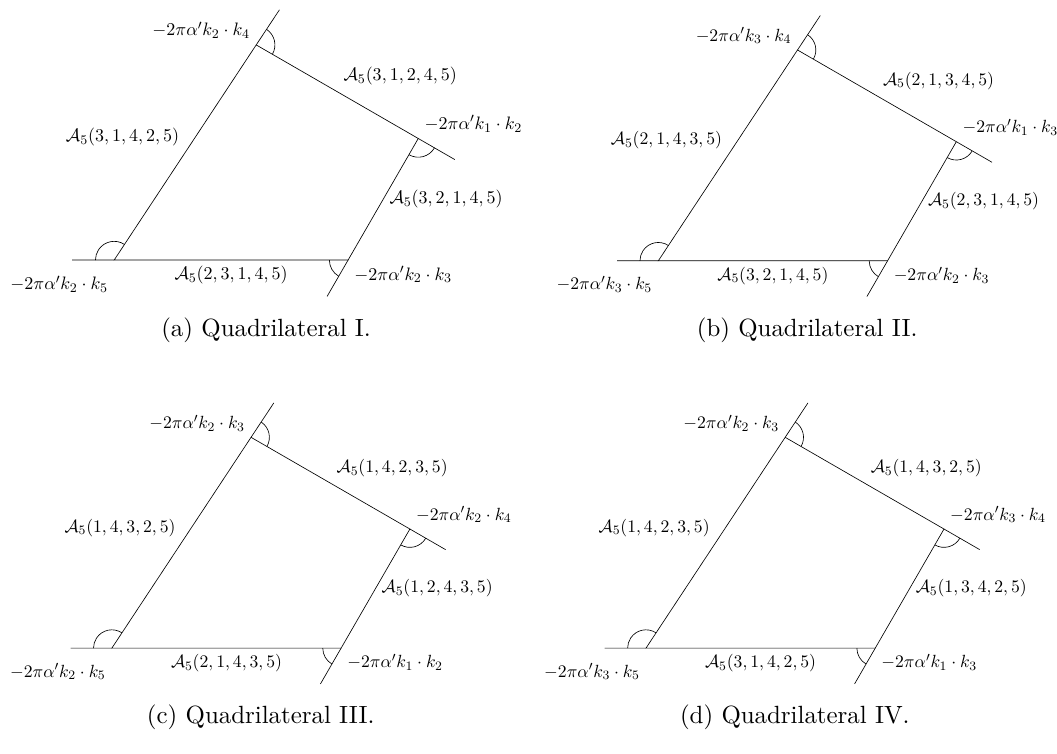
Figure 9. Plahte diagrams for 5-point tachyonic